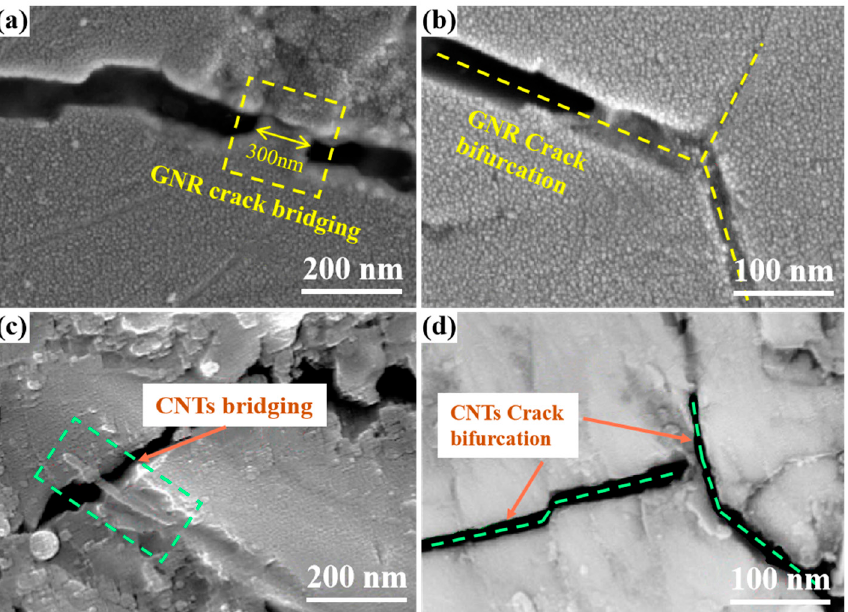
Figure 12. High magnification finite element scanning electron microscope image. ( a , b ) crack bridging and deflection of TiC CNT, ( c , d ) crack bridging and deflection of TiC GNR.